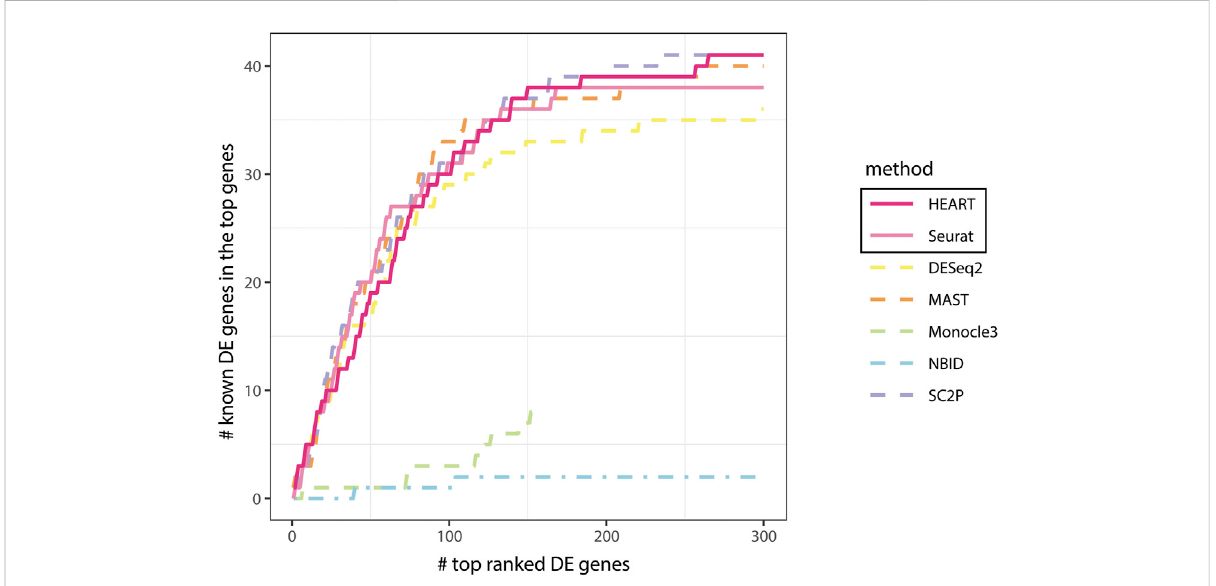
FIGURE 3 Comparing all methods: known DE genes among the top ranked DE genes in human brain cells for astrocytes and oligodendrocytes